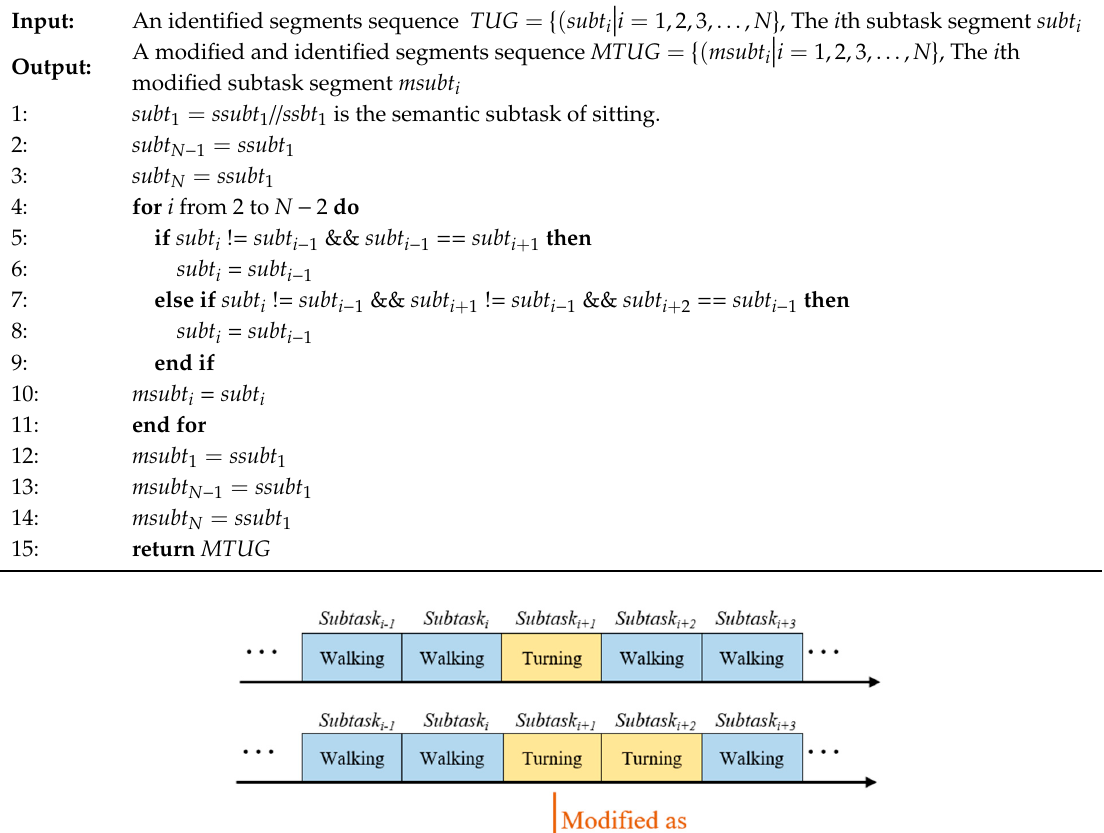
Algorithm: Fragmentation modification algorithm in the knowledge-based postprocessing stage